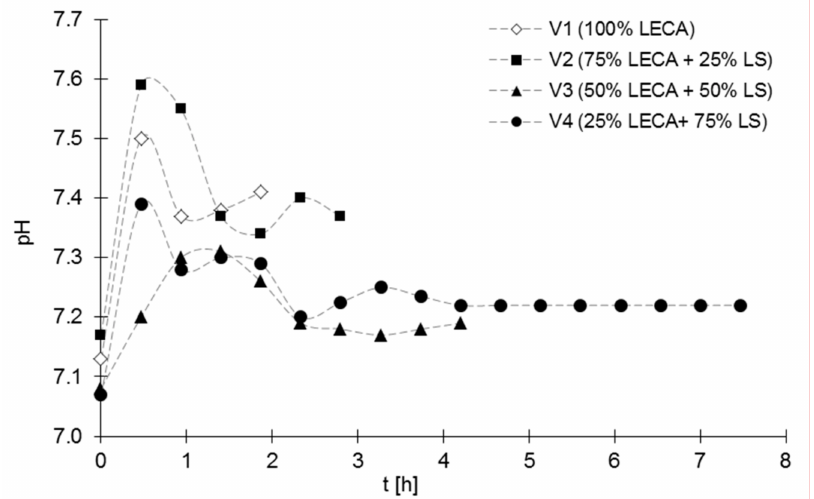
Figure 3. The pH of the hypolimnetic water during treatment on the column beds (LS: limestone); dashed lines were used for better visibility of the trends. Results were presented for the time of effective sorption (OP removal rate of ≥ 10 ±